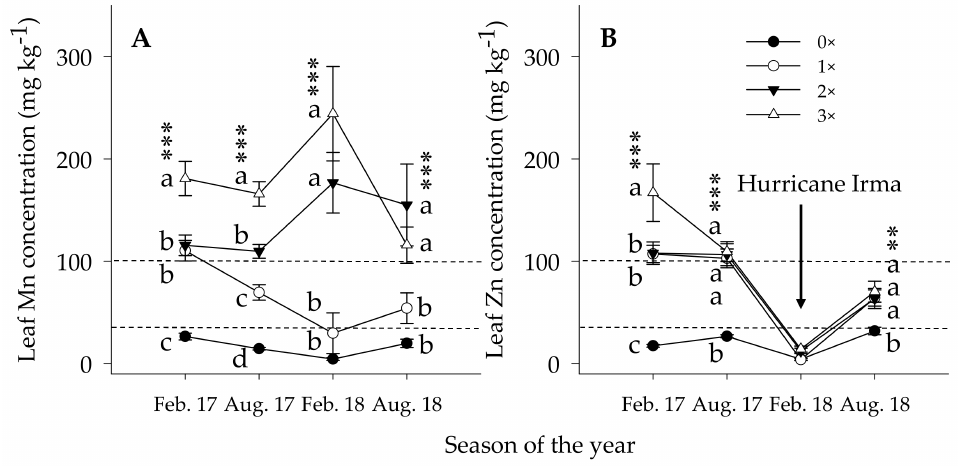
Figure 6. Leaf Mn (figure ( A )) and Zn (figure ( B )) concentration in spring (sp, Feb. /Mar) and summer (su, Aug. /Sept.) seasons of 2017–2018 growing seasons of Valencia citrus trees. Micronutrient treatments: control [0 × , closed circles], foliar (1 × ) (1 × , open circles), foliar (1 × ) and ground (1 × ) (2 × , closed triangles), and foliar (1 × ) and ground (2 × ) (3 × , open triangles), (1 × = 9 kg ha − 1 of metallic Mn and Zn each and 2.3 kg ha − 1 of B). No data for trees on Volk as Hurricane Irma removed the trees in summer 2017. Asterisks: **, *** indicate significant at p ≤ 0.01, p < 0.0001, respectively. The space between the two broken lines indicates the optimum range of leaf nutrient concentrations. Means along the same vertical alignment with the same lower case letters are not significantly different ( p ≤ 0.05) using the Tukey’s range